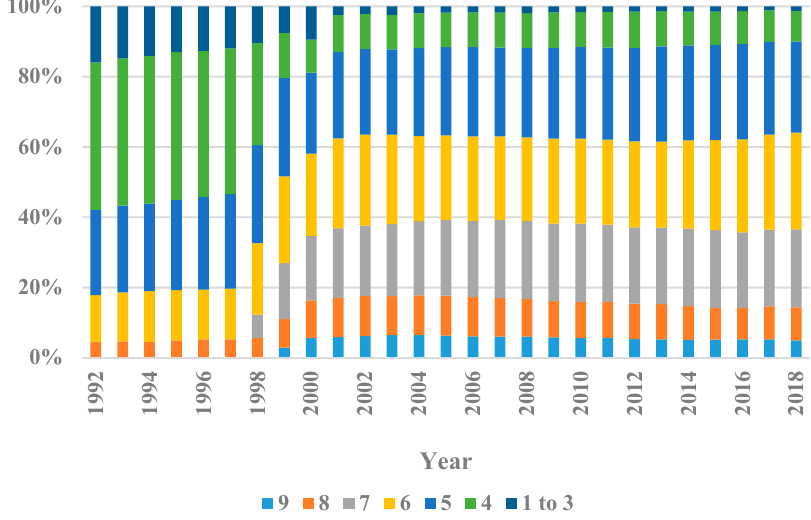
Figure 2. Percentage of each condition value from 1992 to 2018.